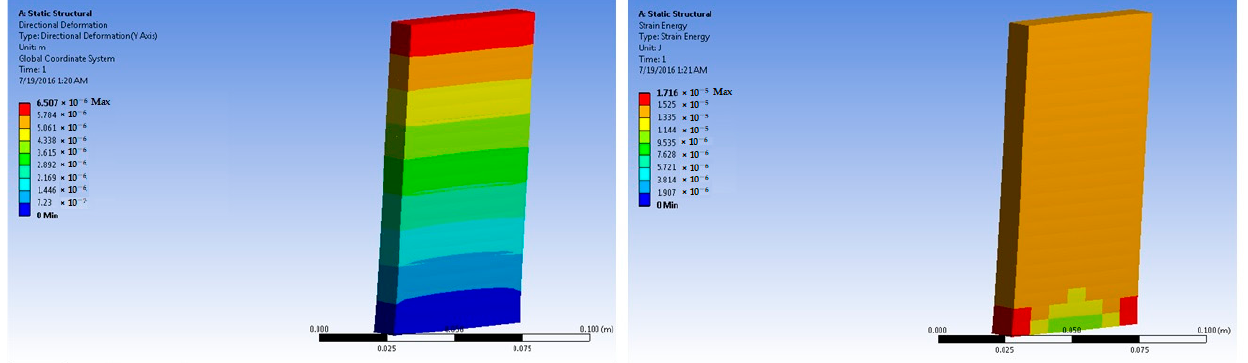
Figure 19. Three percent fine-aggregate-based concrete slab at 50 × 10 5 N force (deformation and strain energy).